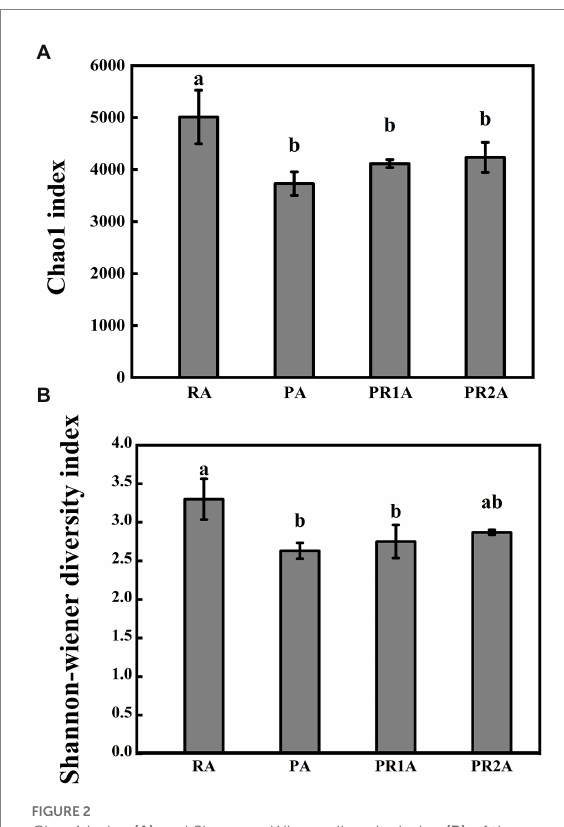
FIGURE 2 Chao1 index (A) and Shannon-Wiener diversity index (B) of the reed area (RA), poplar planting area (PA), poplar retreat for 1-year area (PR1A) and poplar retreat for 2 years area (PR2A) in March 2021. The vertical line above the histogram correspond to standard errors, while significant differences ( p < 0.05) represented by different letters.